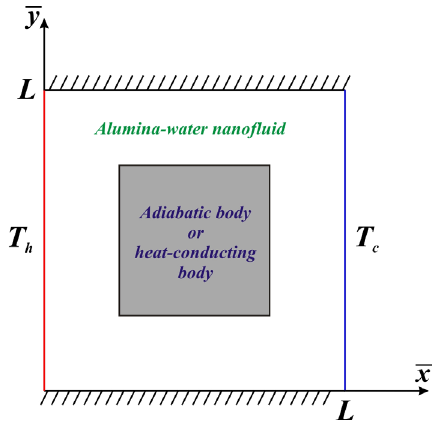
Figure 1. Sketch of the problem.